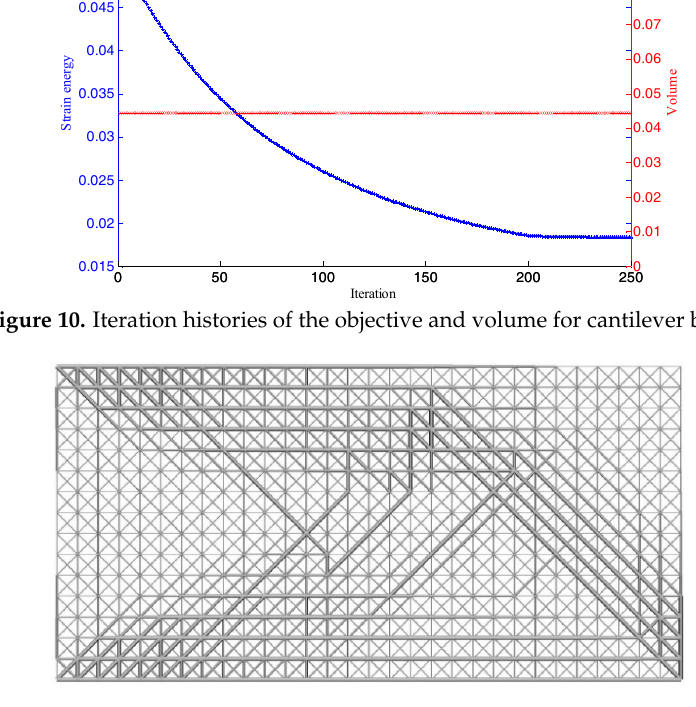
Figure 11. Final optimized structure of the cantilever beam.